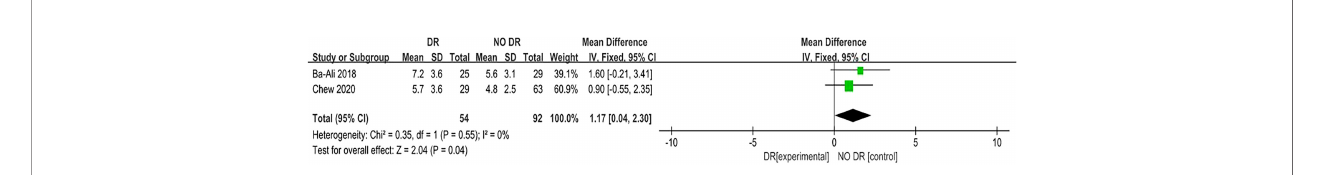
FIGURE 6 | Forest plot of ESS score and DR risk relationship meta-analysis.